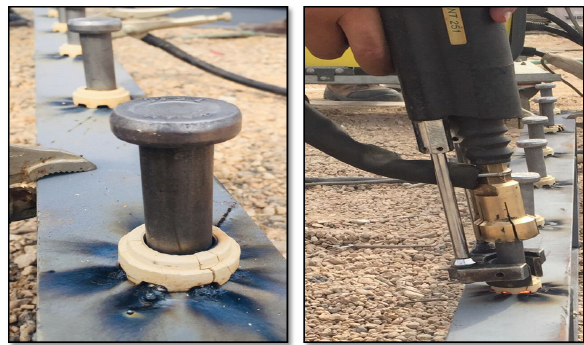
Figure 7: Welding of the studs on flange of steel beams